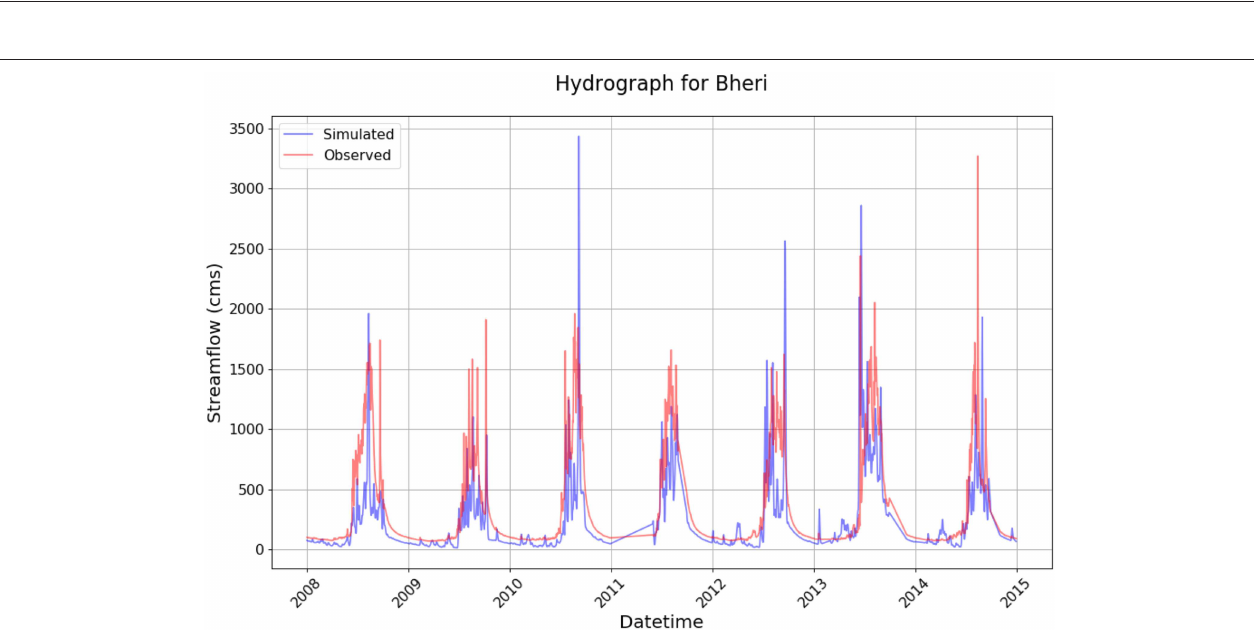
FIGURE 11 | Hispaniola HydroViewer displaying both the Flash Flood Guidance and the Global Streamflow Prediction systems.